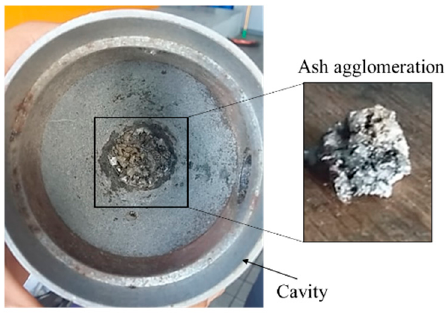
Figure 11. Ash agglomeration at the bottom of the conical cavity.